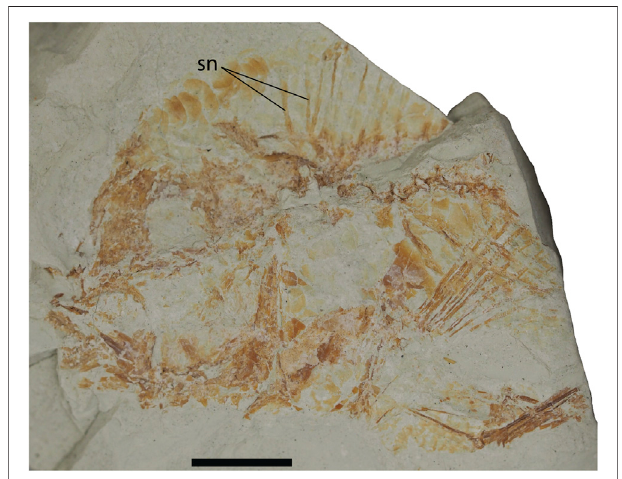
FIGURE 3 | Photograph of the head of Somalichromis hadrocephalus gen. et sp. nov., paratype NHMUK P.29575. Scale bar equals 1 cm.